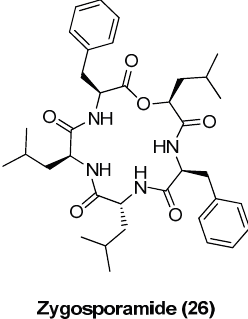
Figure 5. Structure of zygosporamide ( 26